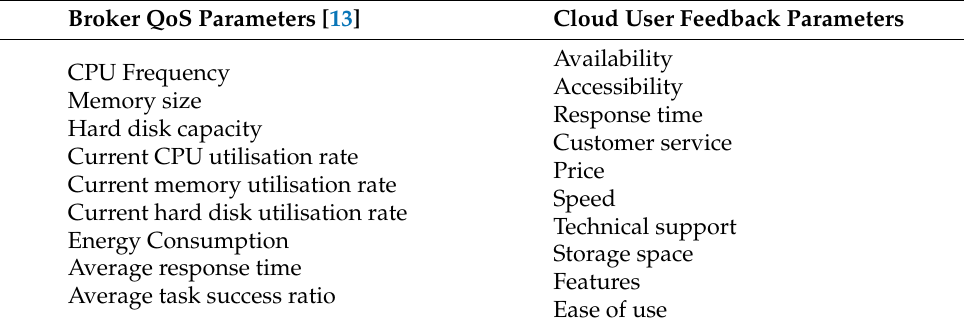
Table 2. Cloud Service Trust